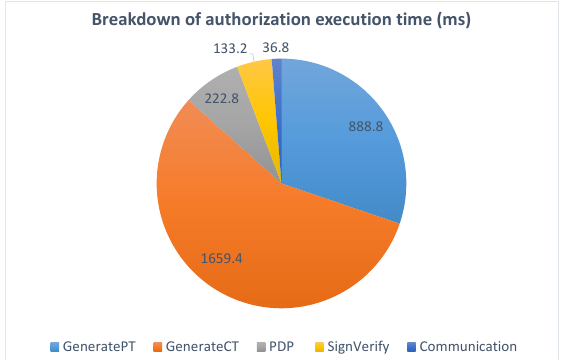
Figure 11. PoC implementation breakdown of authorization execution time.